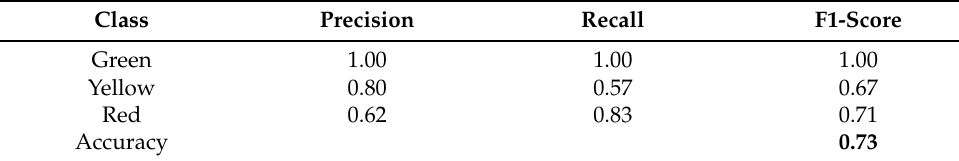
Table 7. Classification report for the LGBM classifier.